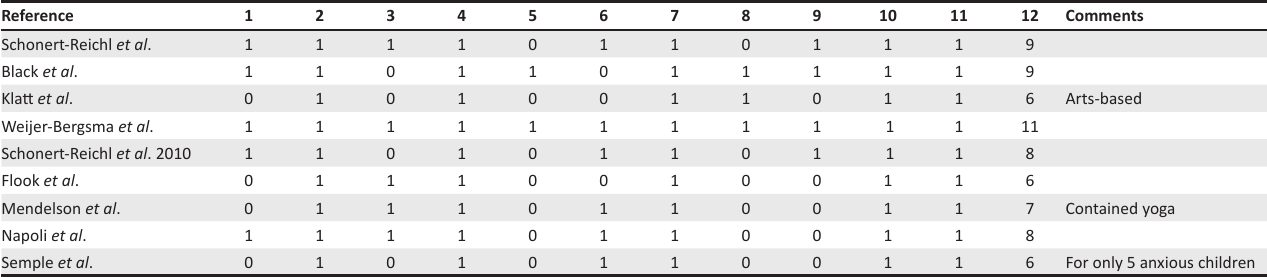
TABLE 4: Methodological validity of the intervention studies.